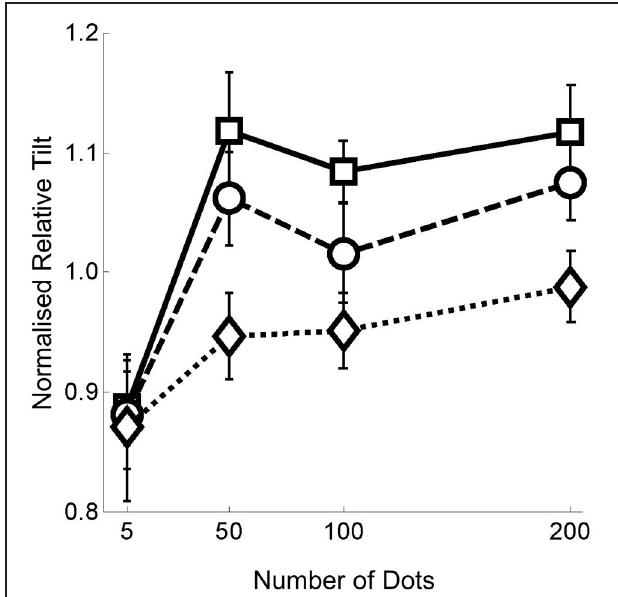
FIGURE 4 | Data from experiment 1 with number of dots per frame on the horizontal axis, and normalized relative tilt on the vertical axis. The three different plots on each graph represent the data for the three noise levels—squares with solid lines for no noise; circles with dashed lines for noise level 1; and diamonds with dotted lines for noise level 2. Error bars represent standard